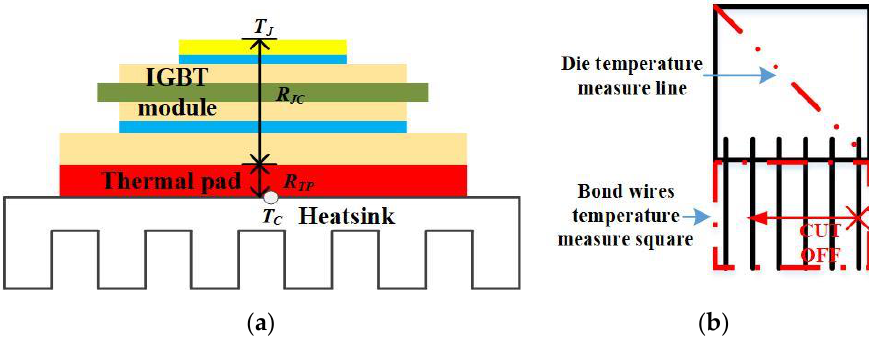
Figure 13. ( a ) Measured thermal resistance ( b ) Measured method.